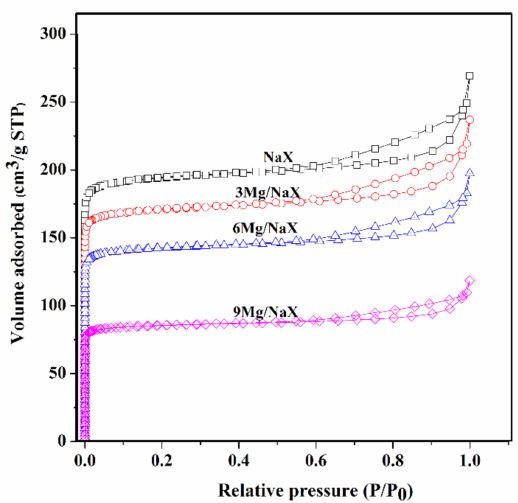
Figure 3. N 2 sorption isotherms of bare NaX and catalysts with various magnesium